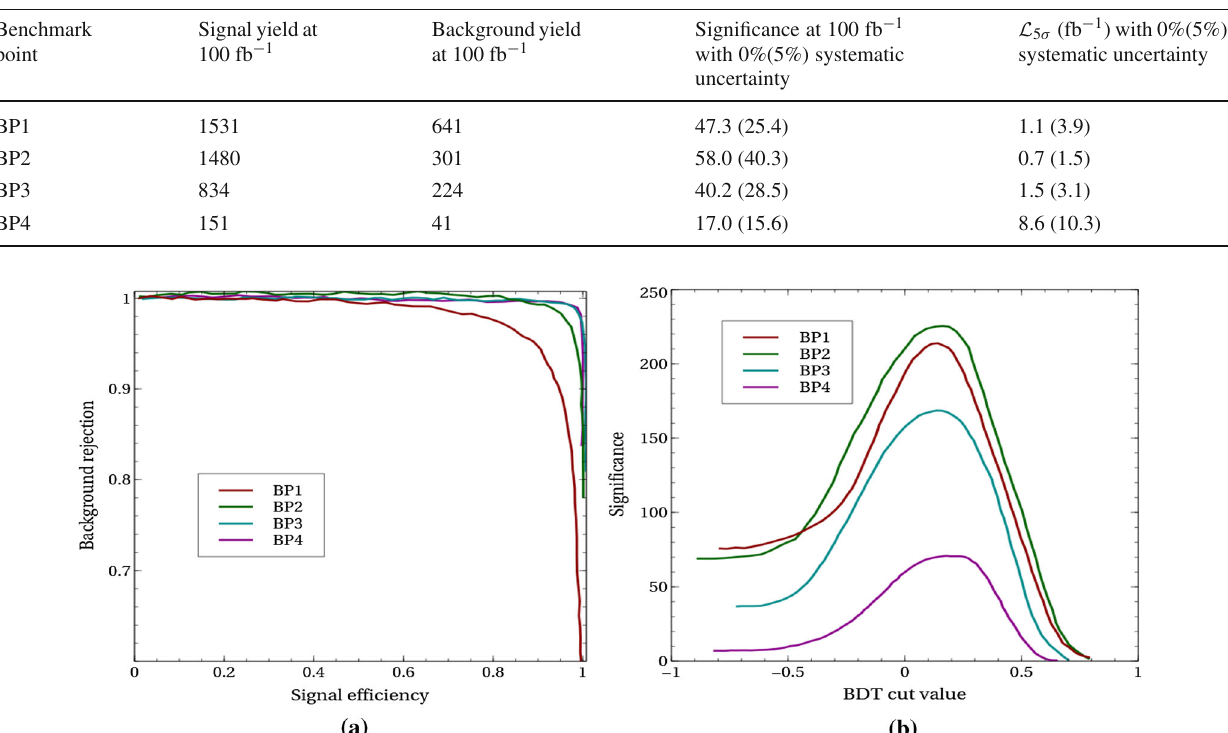
Fig. 5 a ROC curves for chosen benchmark points for 1 (cid:10) + 2 j + E / T channel. b BDT-scores corresponding to BP1, BP2, BP3 and BP4 for 1 (cid:10) + 2 j + E / T